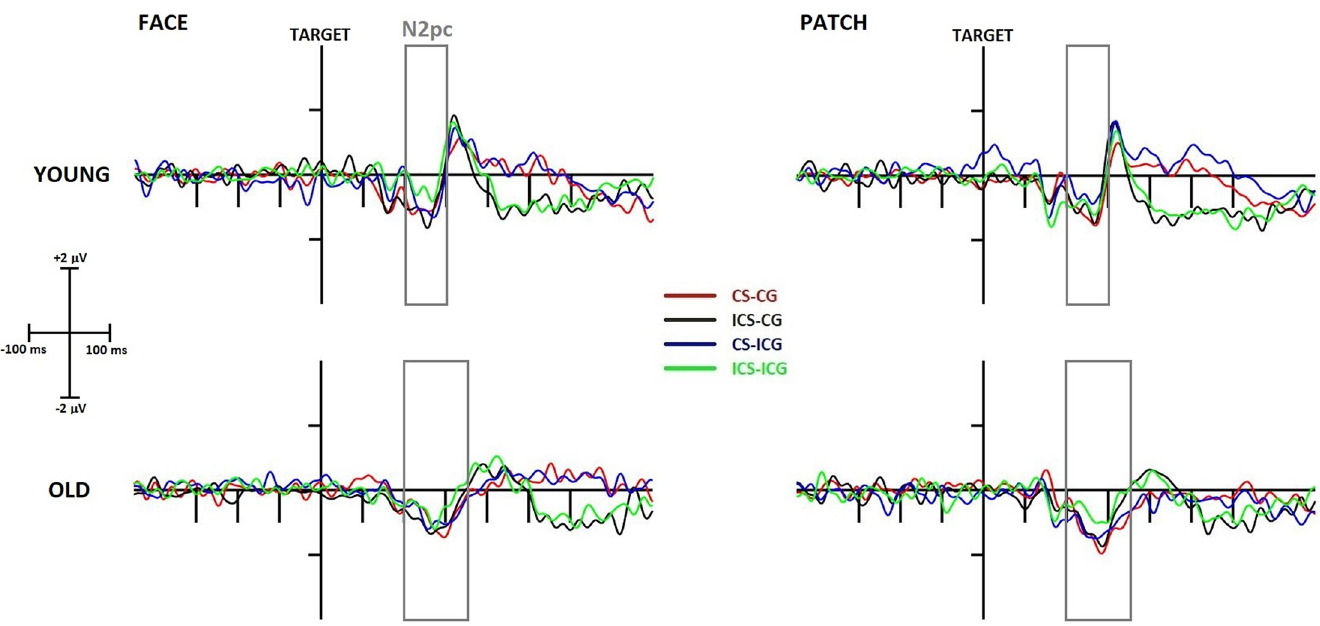
Fig 5. Target-locked N2pc component at the P7-P8 electrode difference (contra-minus-ipsilateral to the presentation side of the target stimulus) in young (top row) and older (bottom row) adults and in face (left side) and patch (right side) trials. The x-axis represents the epoch from -450 ms to 800 ms around the time- point of target presentation. CS-CG (congruent Simon, congruent gaze) waveforms are displayed in red, ICS (incongruent Simon)-CG waveforms in black, CS-ICG (incongruent gaze) waveforms in blue, and ICS-ICG waveforms in green. Grey rectangles represent the search window for maximal N2pc amplitude.